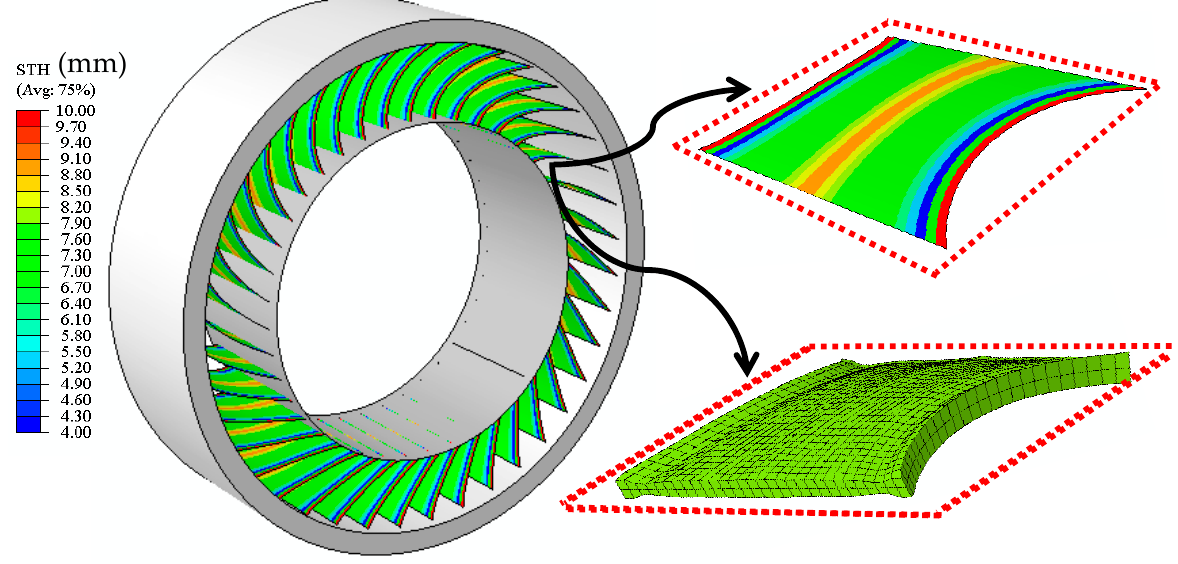
Figure 14. Optimized thickness distribution for thickness in tire-width direction.